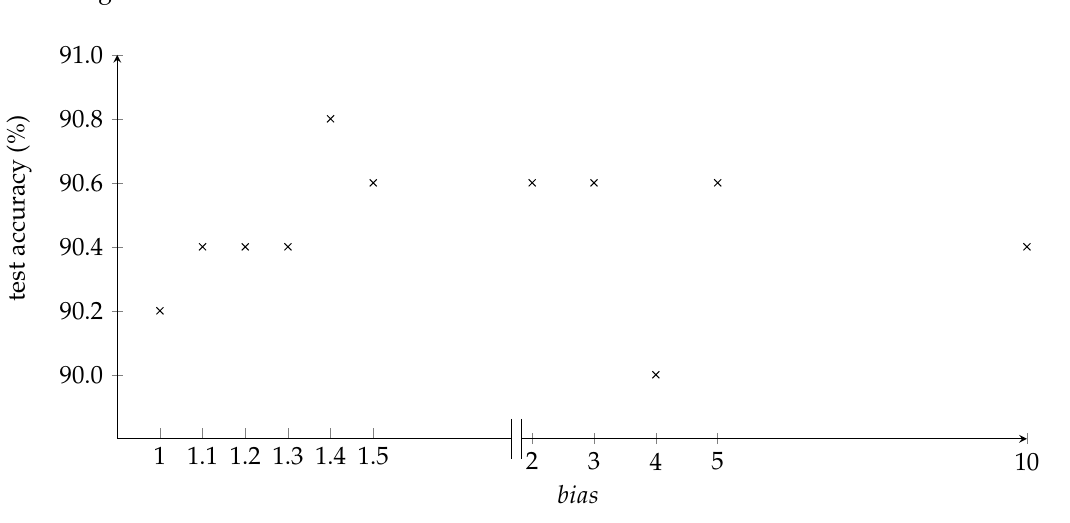
Figure 7. Experiment on different bias values for multiplying weights of background objects when